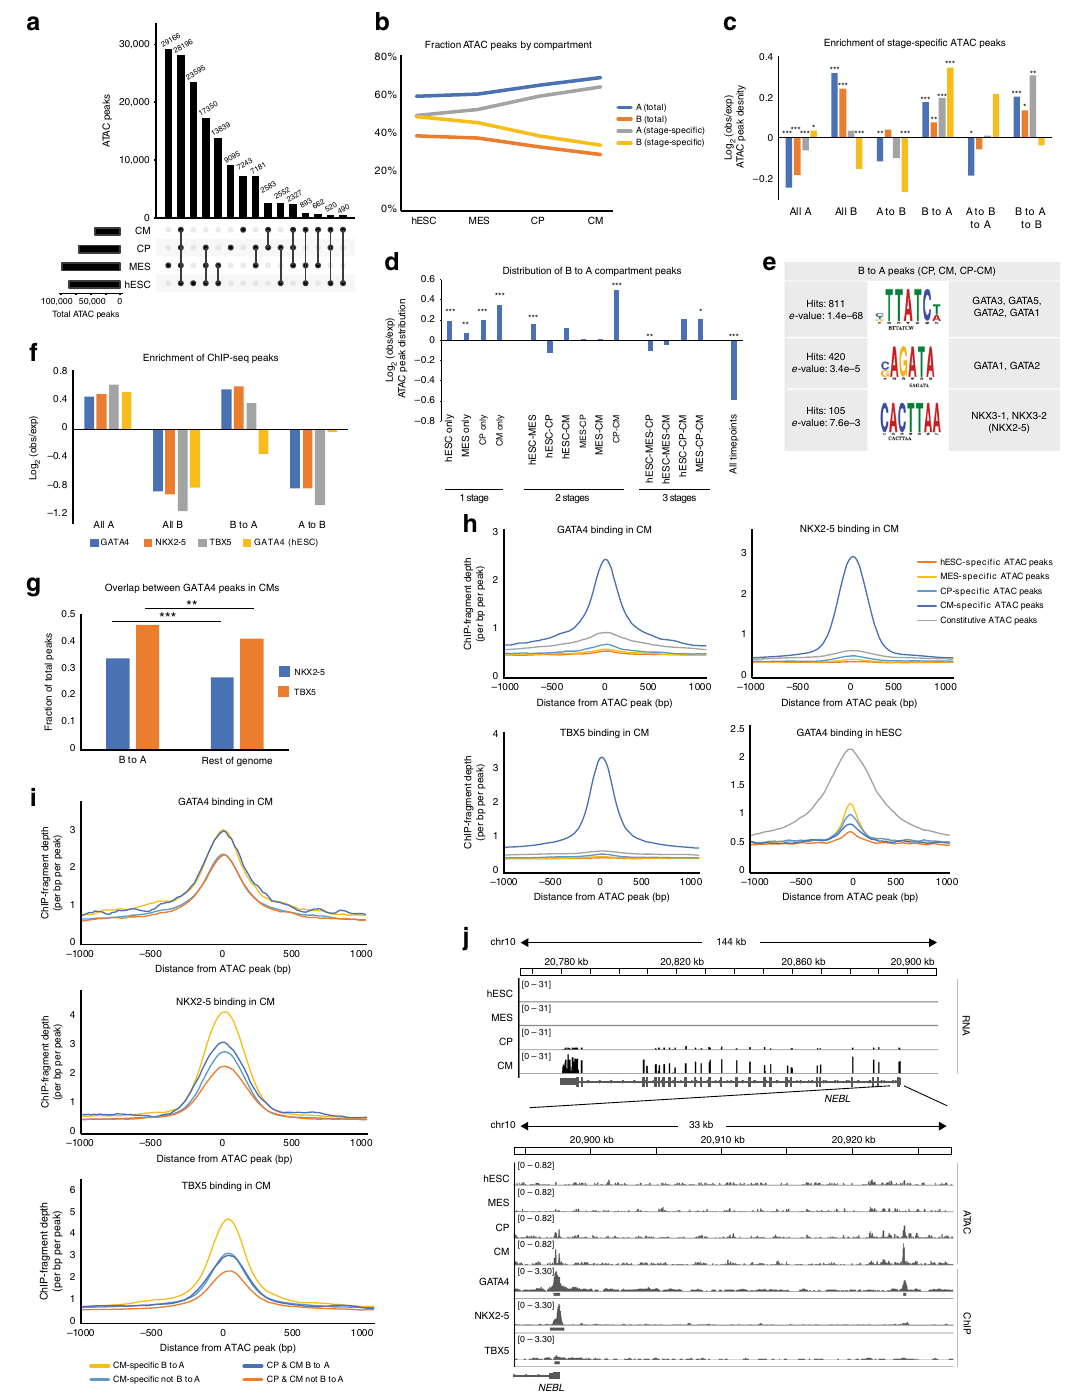
Fig. 4 Changes in local chromatin accessibility occur coincident with global architecture changes. a ATAC peaks across differentiation. b Fraction of ATAC peaks divided by A and B compartment for stage speci fi c and total peaks. c Enrichment of stage-speci fi c ATAC peaks within A/B compartments. Log 2 values are observed/ATAC peak density; p -values by chi-squared test for the indicated ATAC peak set overlaps, * < 0.05, ** < 0.01, *** < 0.001. d Enrichment of peaks within the B to A compartment regions by stage speci fi city, normalized to ATAC peak density. Plot and statistical analysis as in panel ( c ). e Motifs from DREME and TOMTOM within CP and CM-speci fi c peaks in B to A compartment bins. f Enrichment of GATA4, NKX2-5, TBX5 (CM), and GATA4 (ESC) ChIP-seq peaks within constitutive A and B regions and B – A and A – B regions. g Overlap of GATA4 peaks with NKX2-5 and TBX5 in B – A regions or the rest of the genome. p -values by chi-squared test for the indicated ChIP-seq peak set overlaps, *** < 0.001. h Metaplot of GATA4, NKX2-5, TBX5 (CM), and GATA4 (ESC) binding across stage speci fi c and constitutive ATAC peaks. Peaks are centered at the mid-point of ATAC peaks and extended ± 1000 bp. i Metaplot of GATA4, NKX2-5, TBX (CM) across CM or CP&CM-speci fi c peaks in B – A regions or the rest of the genome. j Gene track of RNA-seq, ATAC-seq and ChIP-seq reads for NEBL gene and promoter region. Source data are provided as a Source Data fi le